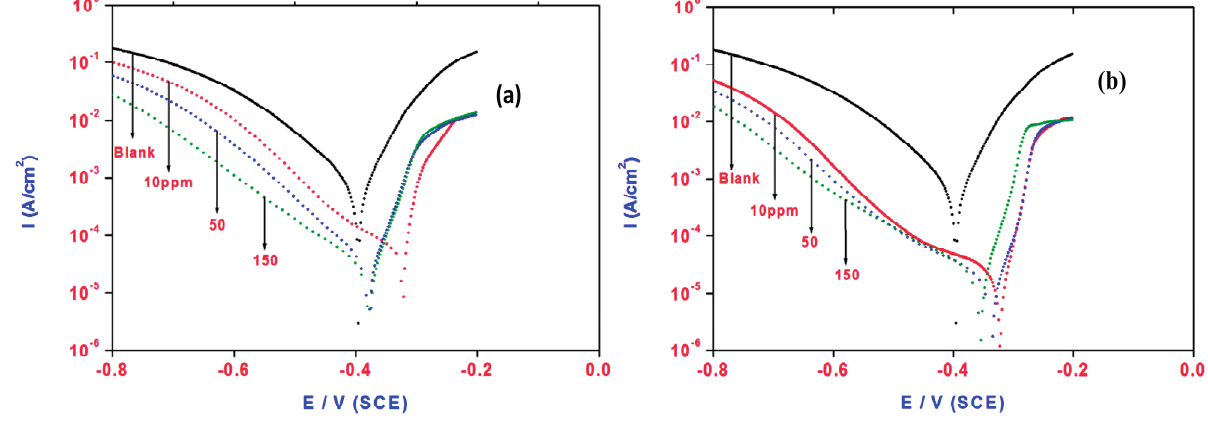
Figure 10. Polarization plots of steel electrode obtained in 1 M HCl solution and containing various concentrations of ( a ) OA-TS and ( b )